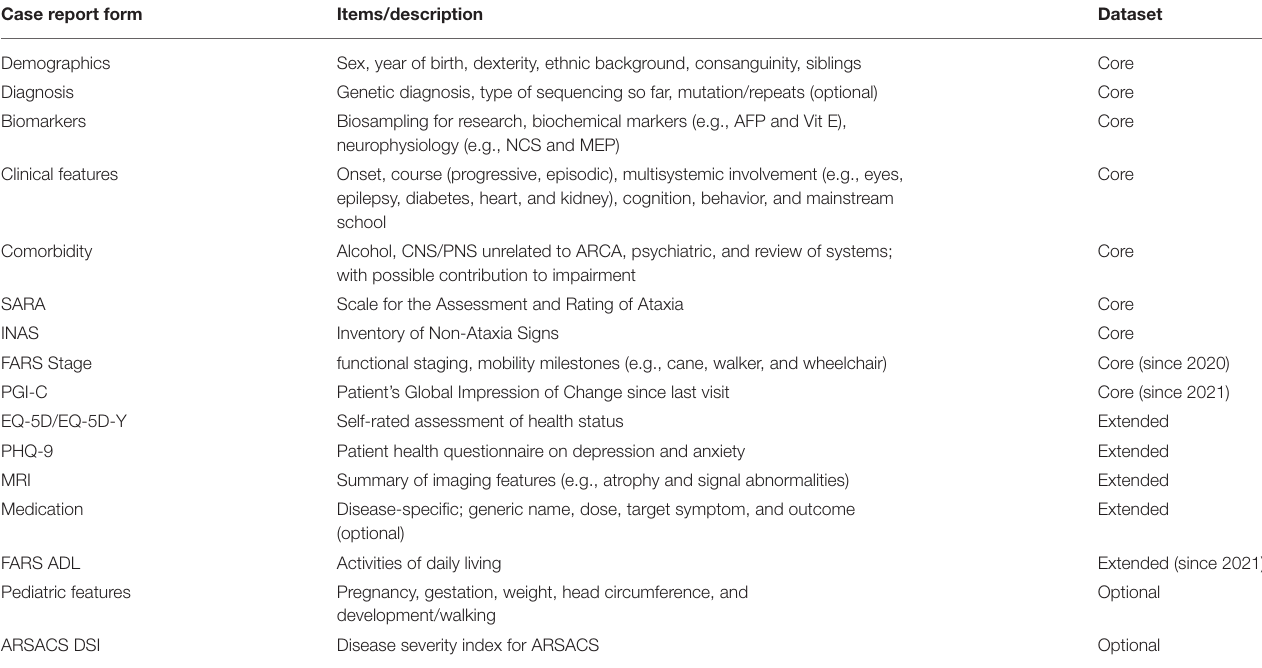
TABLE 1 | Case report forms in the ARCA Registry.